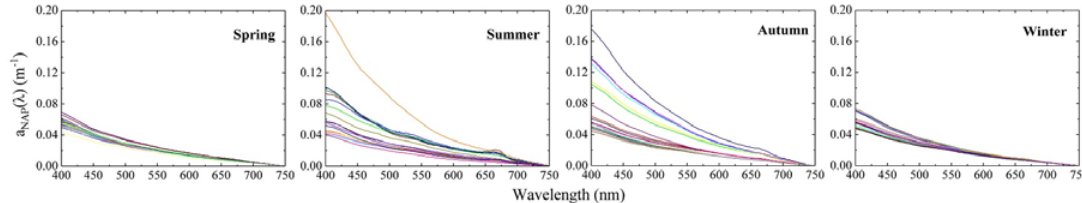
Figure 13. NAP absorption spectra in each season. The curves with different colors in each panel represent the different sampling sites.